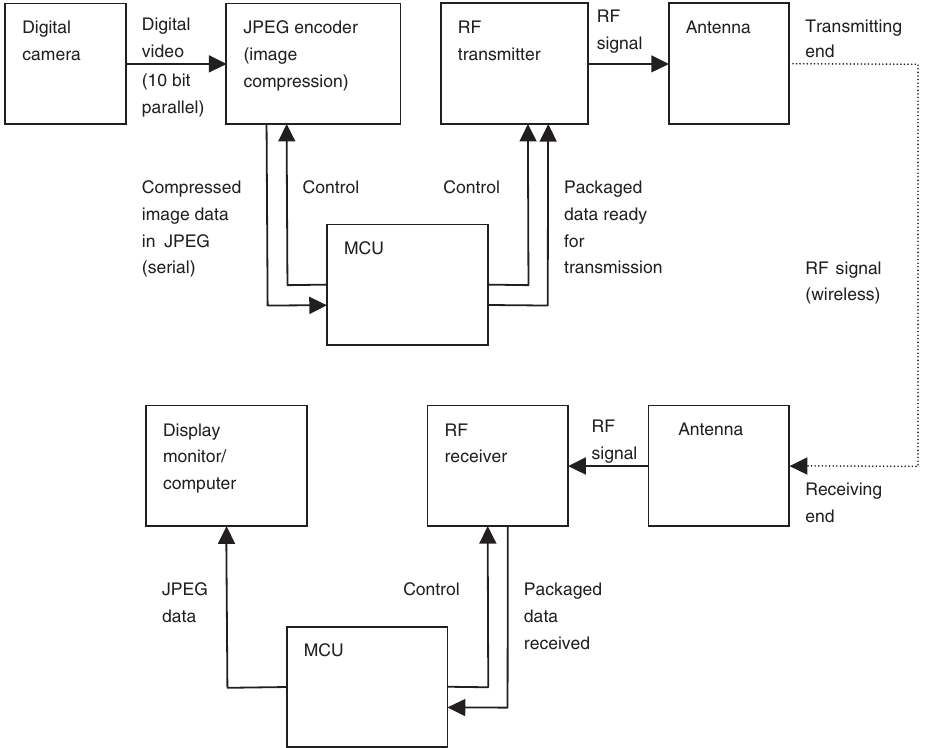
Figure 8 Block diagram of solution 4: digital camera + digital video transmission with video